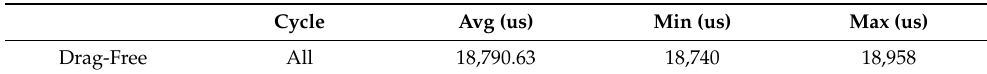
Table 8. The running time of drag-free module.